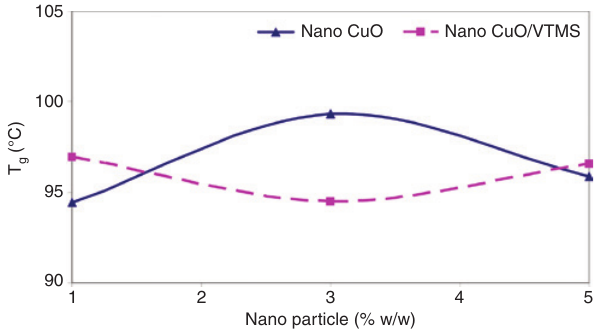
Figure 5: Glass transition temperature for epoxy acrylate/nanoCuO and CuO nanoparticles modified with TEMS.